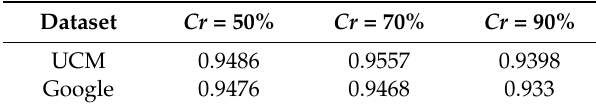
Table 6. Sensitivity analysis in relation to the crop rate Cr .